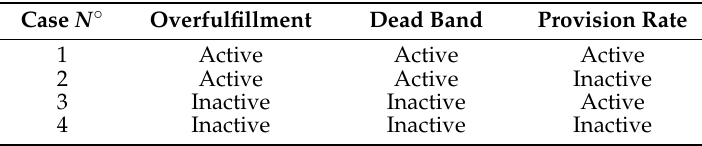
Table 3. Strategy for activating the